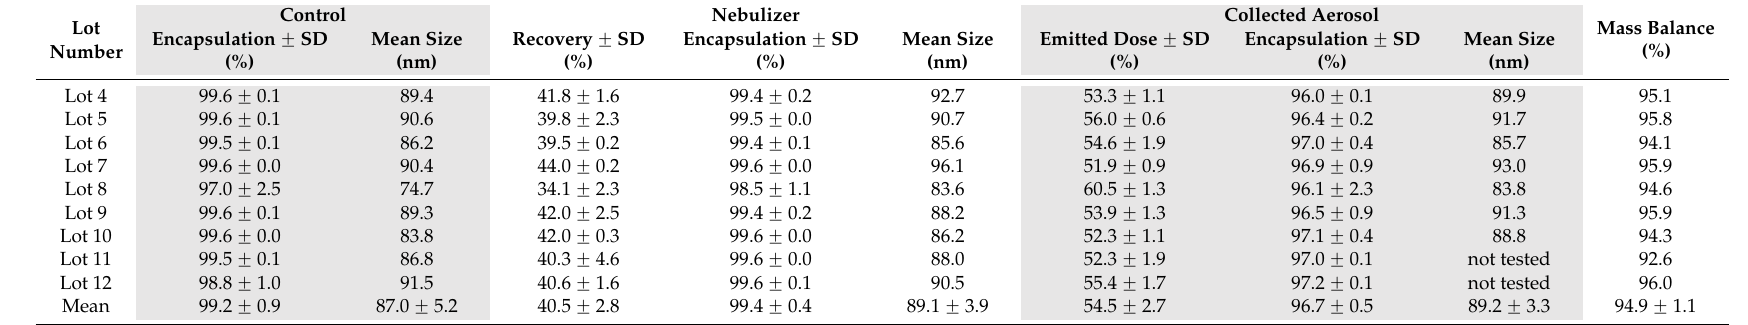
Table 2. GMP batches of Lipoquin retain integrity after 24-month storage at refrigerated conditions and subsequent nebulization. Adapted with permission from [41]. Copyright 2010 RDD